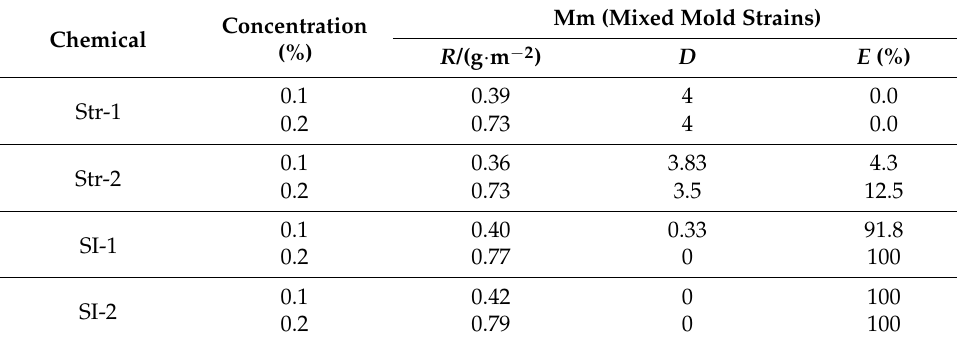
Table 5. Mold resistance of bamboo treated with selected chemicals.